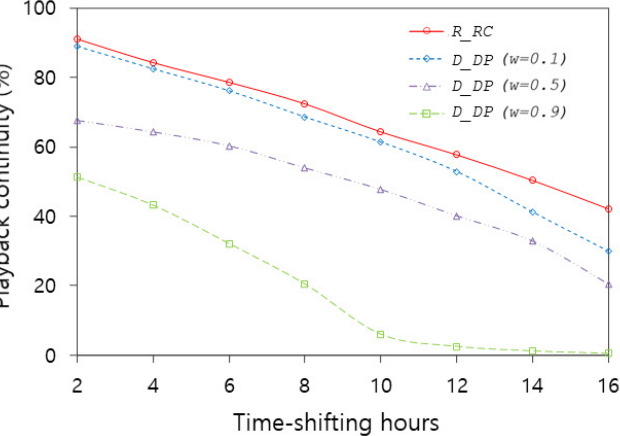
Figure 8. Comparison of playback requests between D _ DP and R _ RP in distribution 1 with a 150 s